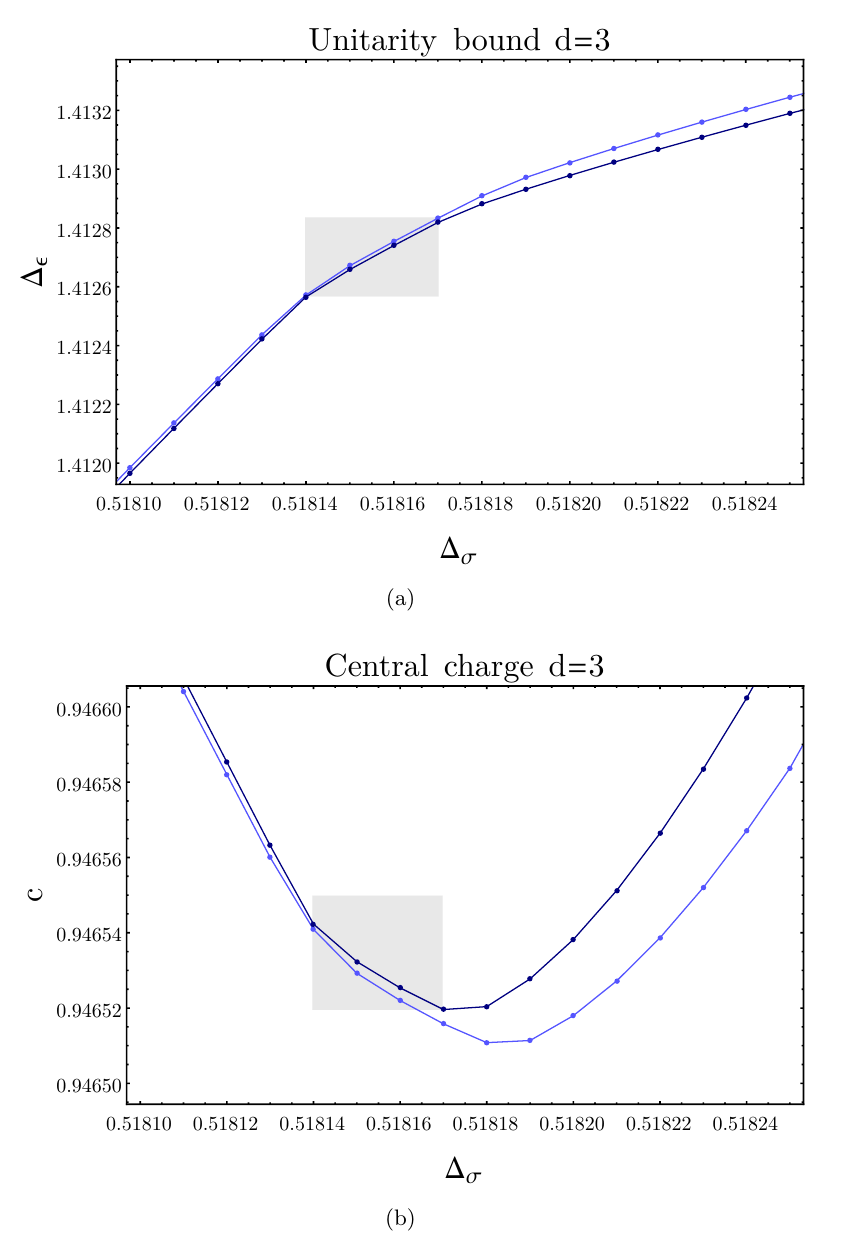
Figure 1 . Determination of the Ising critical point for d = 3 from: (a) kink on unitarity boundary; (b) minimum of central charge. The light (dark) blue lines correspond to bootstrap equations with 153 (190) components. The grey area indicates the estimated